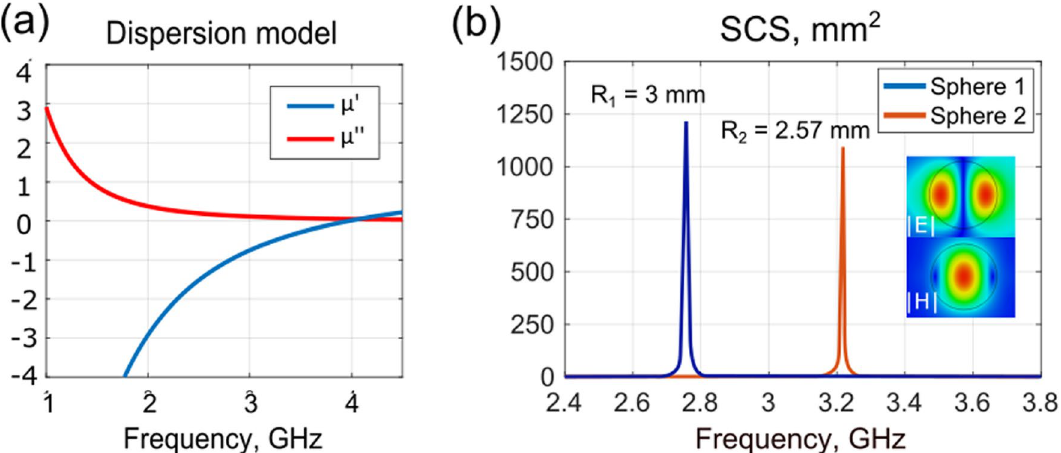
Figure 2. ( a ) Dispersion of a nontrivial permittivity tensor component (Eq. 1). Real and imaginary parts are blue and red lines correspondingly. ( b ) Scattering cross sections of high-index dielectric spheres (radiuses are